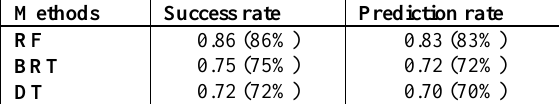
Table 4. Success and predication rates for RF, DT, and